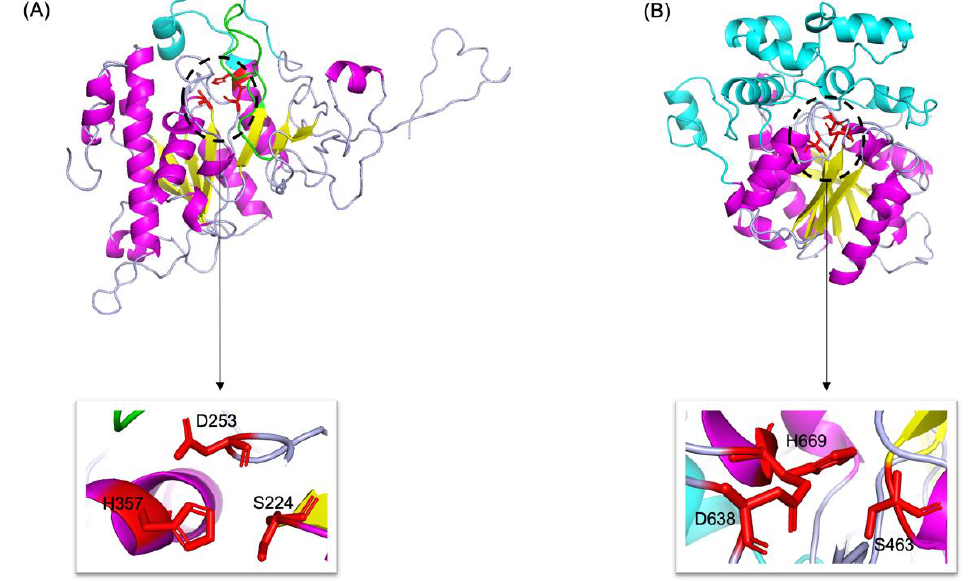
Figure 5. 3D structures of neutral ( A ) and acid ( B ) lipase in fig wasp. α -Helices, β -sheets and loops are shown in magenta, yellow and light blue, respectively. The catalytic triads are highlighted by red sticks and zoomed in. In neutral lipase ( A ), the β 9 loop was highlighted by green, and the lid was highlighted by cyan. In acid lipase ( B ), the cap domain was highlighted by cyan.